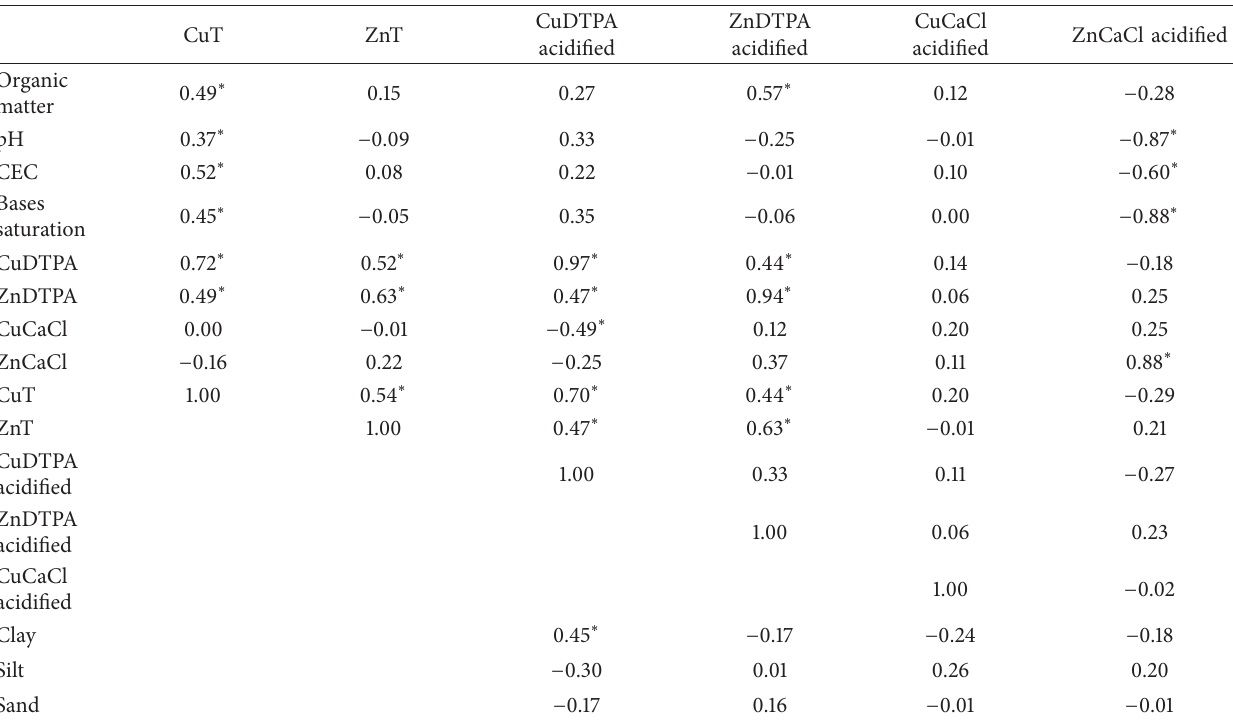
Table 3: Correlation coefficients between forms of Cu and Zn and other soil